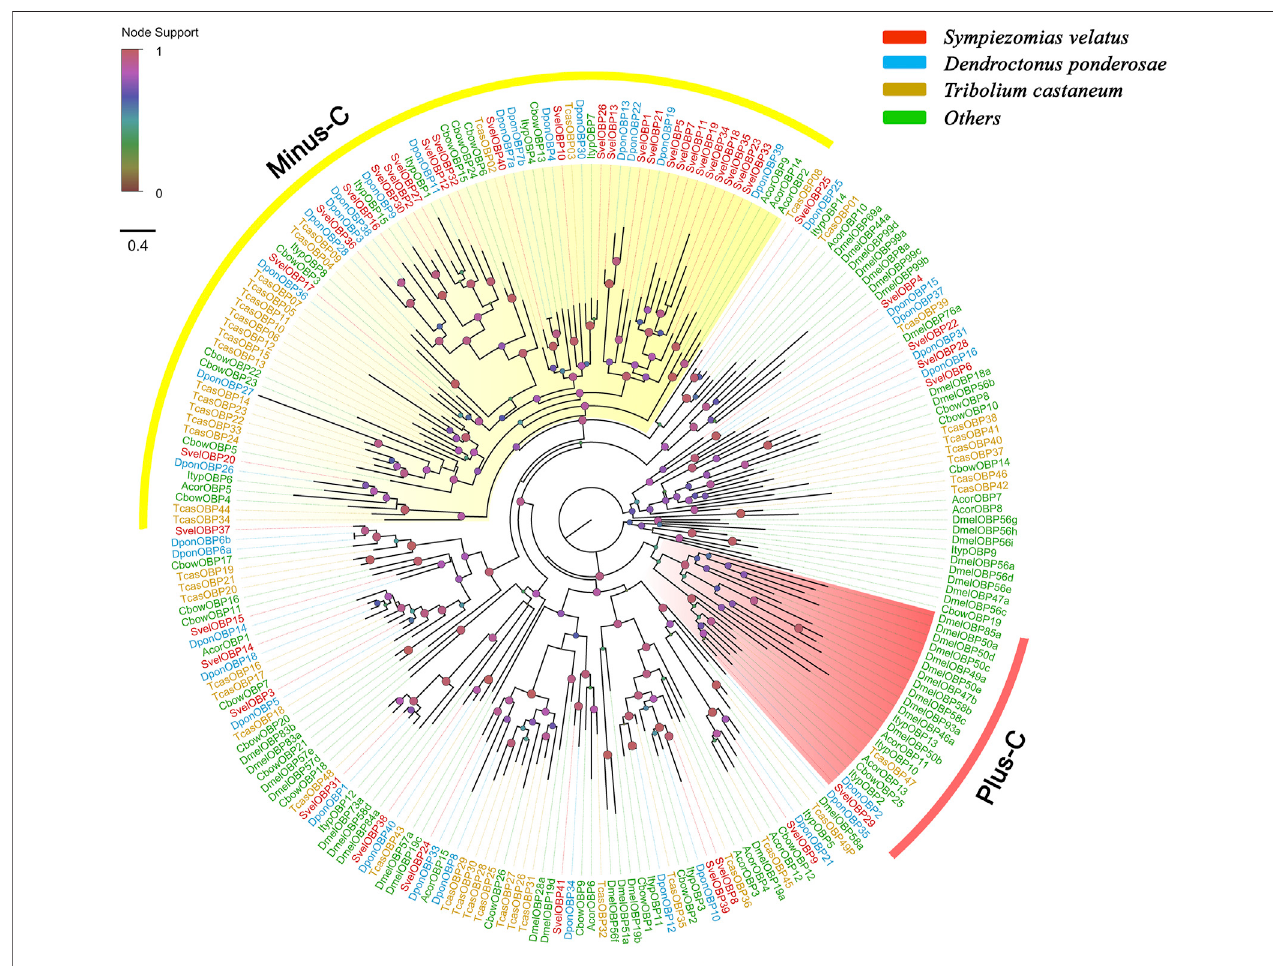
FIGURE 1 | Phylogenetic tree of candidate odorant-binding proteins (OBPs). The OBP sequences included were from Sympiezomias velatus (Svel, red), Dendroctonusponderosae (Dpon,blue), Triboliumcastaneum (Tcas,yellow),andotherspecies(green),including Drosophilamelanogaster (Dmel), Colaphellusbowringi (Cbow), Anomala corpulenta (Acor) and Ips typographus (Ityp). The unrooted tree was constructed using FastTree based on a MAFFT alignment. The local support values based on the Shimodaira-Hasegawa (SH) test are indicated by the colored circles and increase with the brightness and size of the circles.